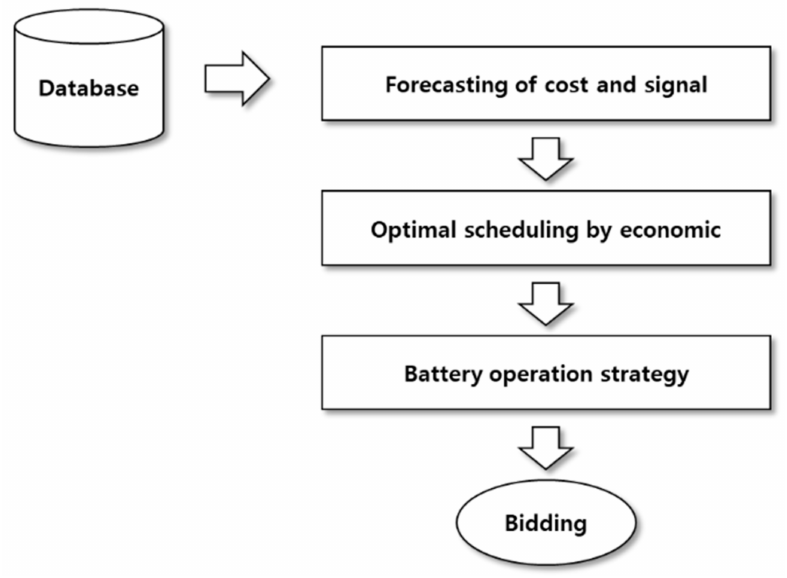
Figure 7. Determination of the bidding in FR market using